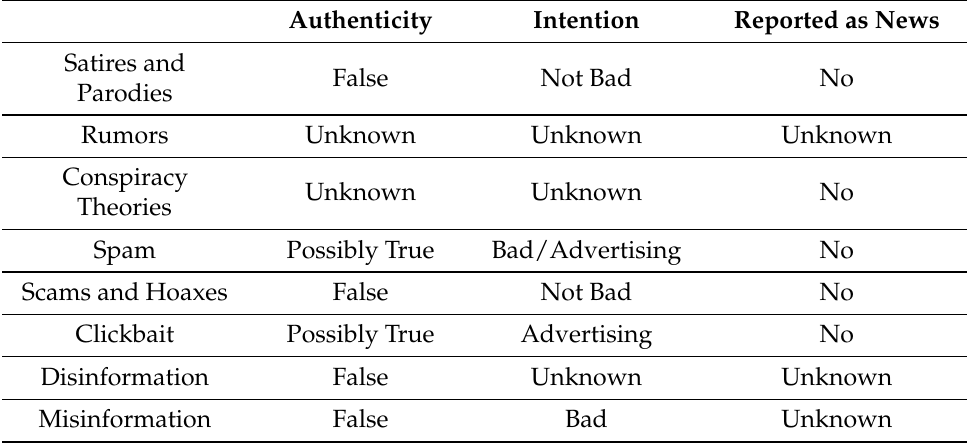
Table 1. Fake news-related terms and